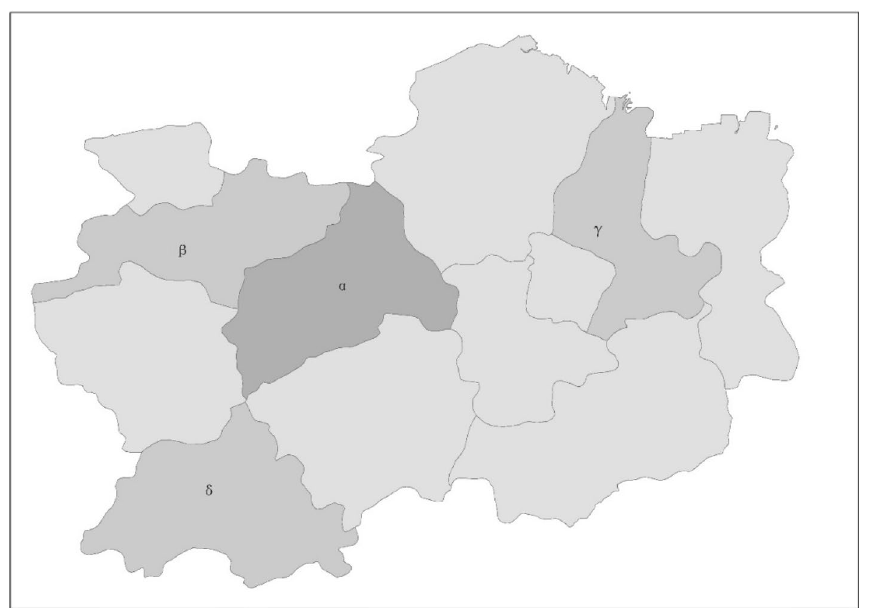
Figure 2. The virtual map of urban agglomeration. (ArcGIS10.2,URL: https:// devel opers. arcgis.